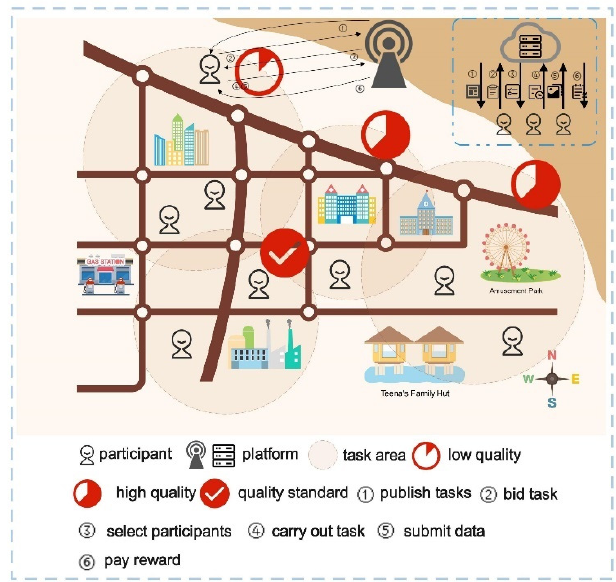
Figure 2. Physical